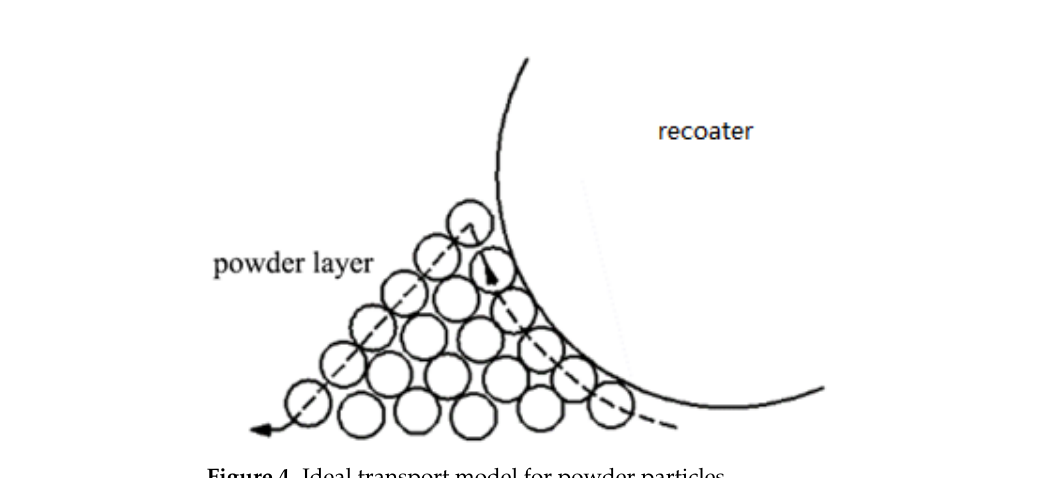
Figure 3. Pattern of accumulation of powder particles.